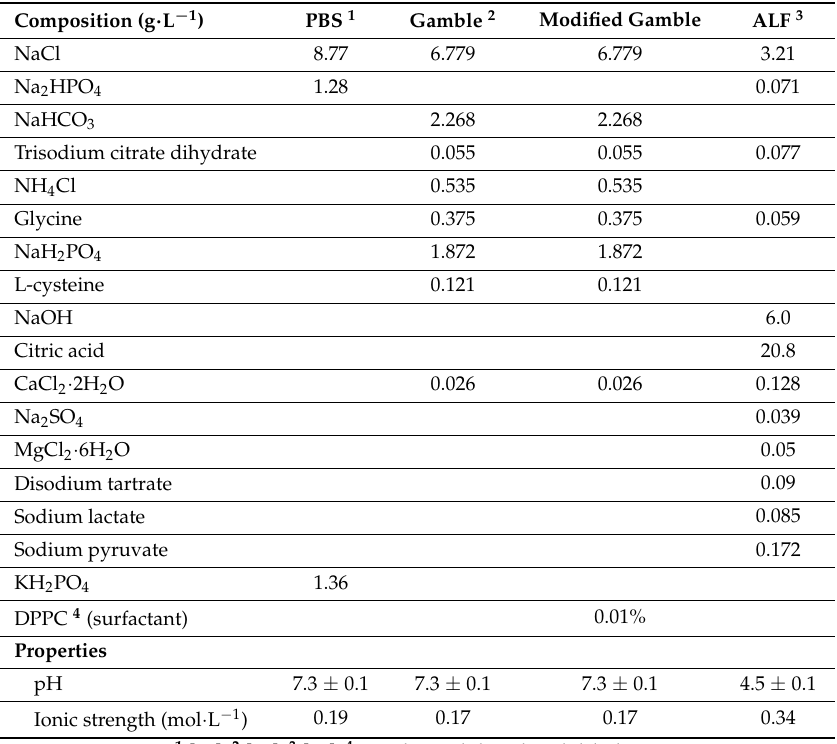
Table 2. Composition and properties of the different simulated lung fluids (SLFs) studied (PBS, Gamble’s solution, modified Gamble’s solution and ALF). PBS: phosphate-buffered saline; ALF: artificial lysosomal